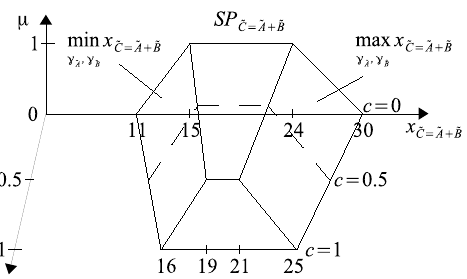
( c , γ ˜ , γ ˜ , µ ) of two B C A